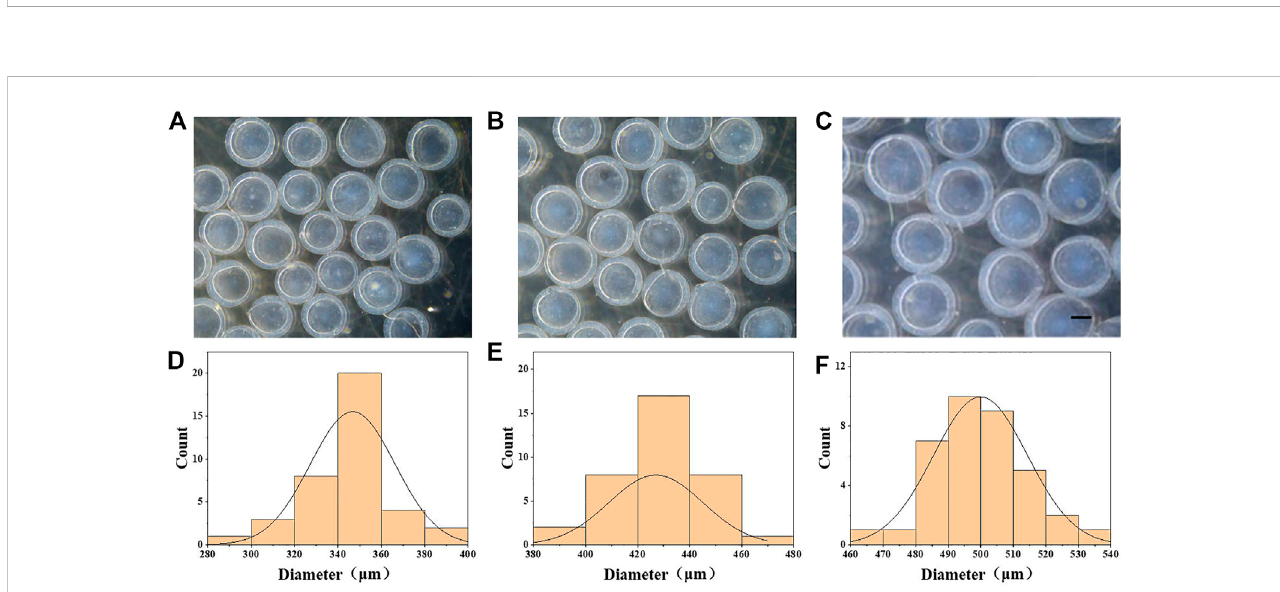
Generation of CMC – ALG microcapsules via micro fl uidic electrospray technology. (A – C) Bright- fi eld microscopic images of the CMC – ALG core – shell microcapsules with different voltages. Scale bar represents 200 μ m. (D – F) Diameter distribution of microparticles under different voltages. (A) 6 kv, (B) 7 kv, and (C) 8